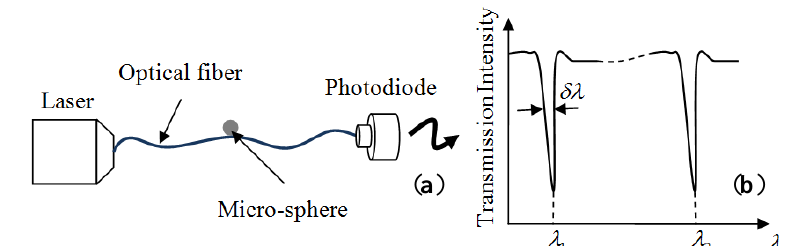
Figure 2. ( a ) Schematic of sensor system and ( b ) observed transmission